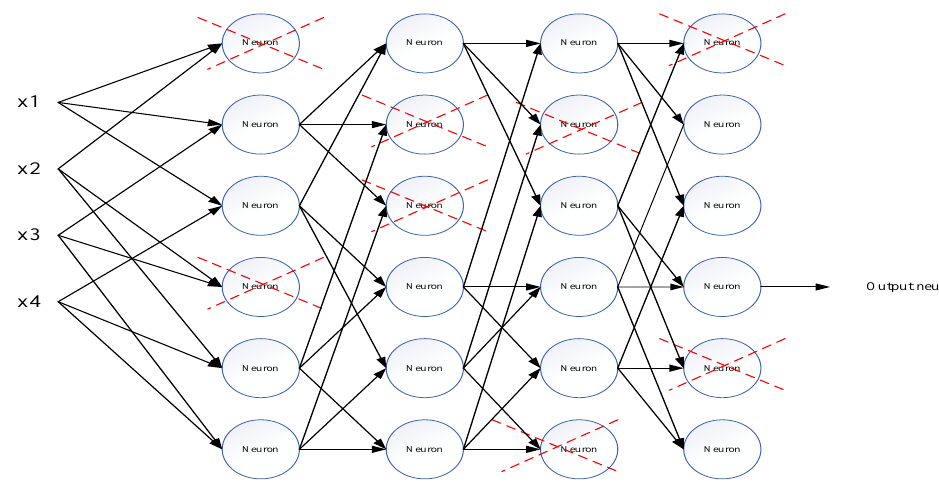
Figure 5. GMDH Artificial Neural Networks.